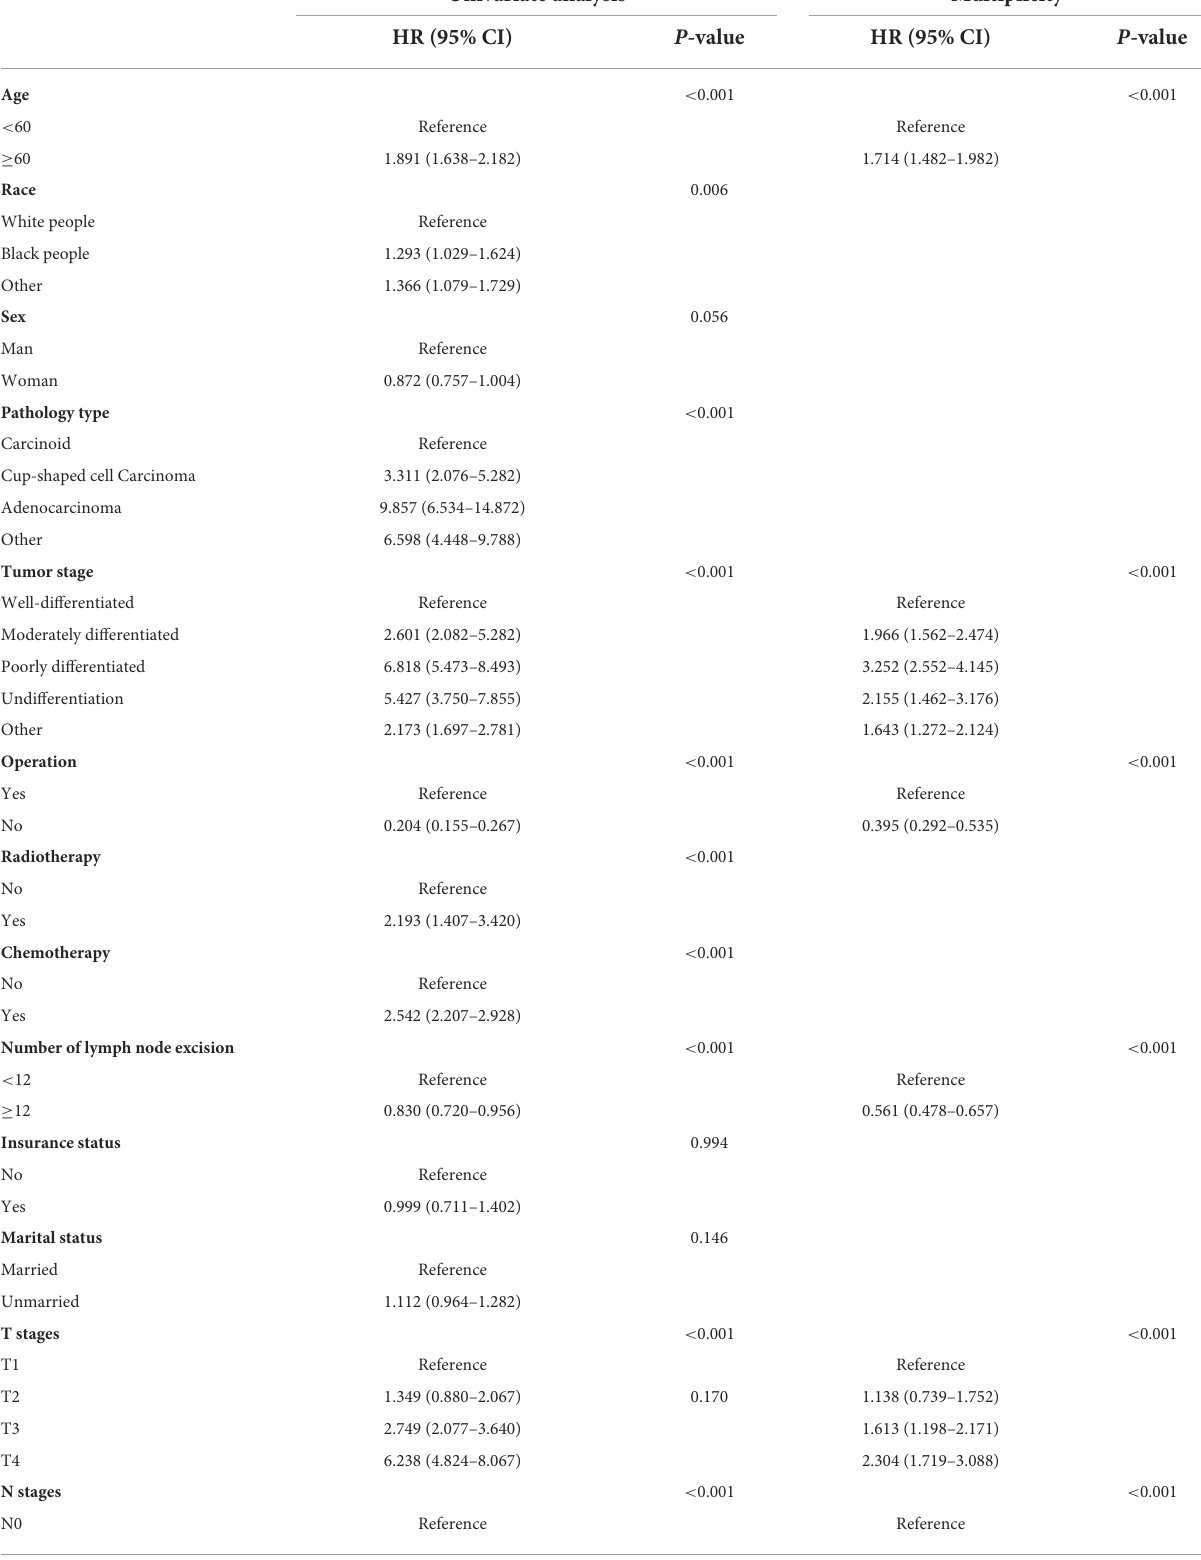
TABLE 2 Univariate and multivariate analysis of appendiceal cancer prognosis. Univariate analysis